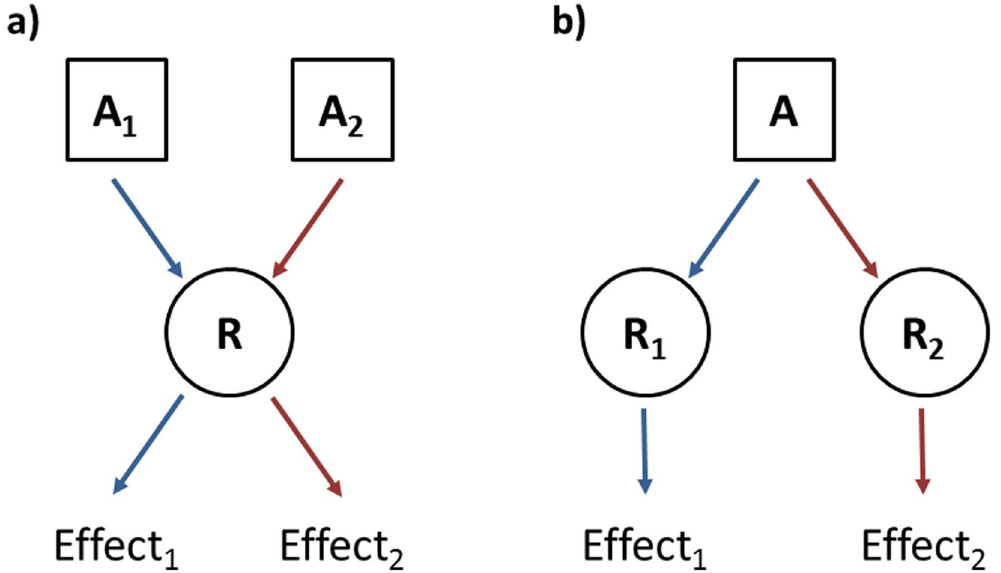
Figure 1. ( a ) Two agonists A1 and A2 activate the receptor R producing effects 1 and 2, respectively. ( b ) Agonist A activates receptors 1 and 2 producing effects 1 and 2, respectively. In the present study ligand A corresponds to MPEP whereas receptors 1 and 2 correspond to mGlu4 and mGlu5,